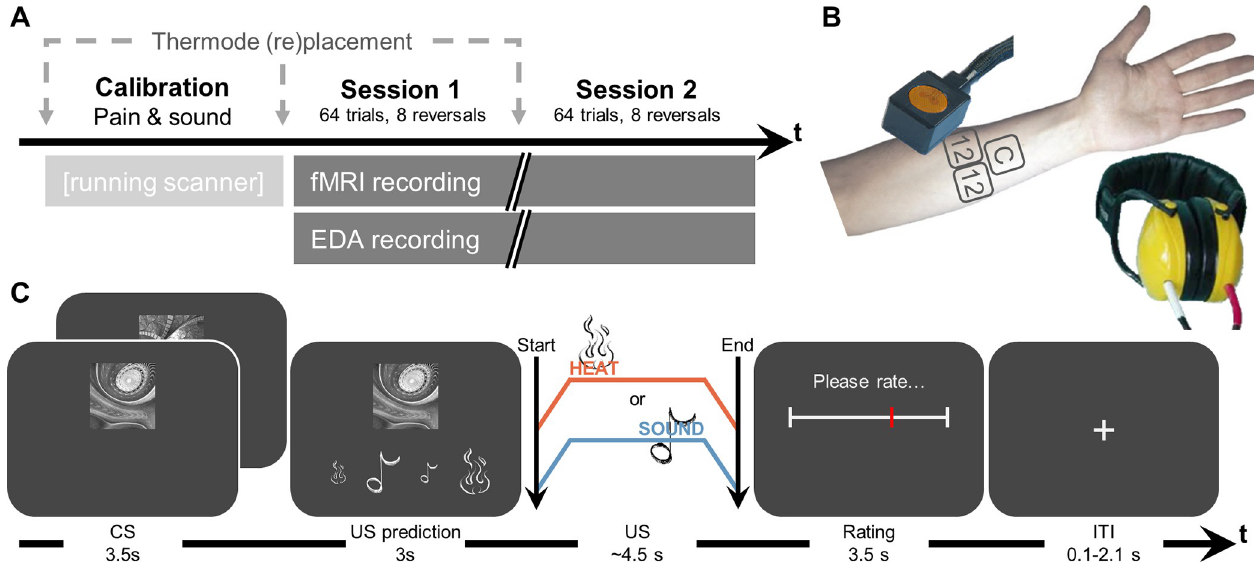
Fig 1. Experimental protocol. (A) Overall structure of the experiment. Calibration took approximately 15 minutes, each session approximately 20 minutes. (B) Devices used for heat stimulation (thermode) and sound stimulation (headphones), with standardized locations on the left arm for pain calibration and either of the 2 experimental sessions. (C) Trial structure with associated durations. After displaying CS, participants were asked to choose which US they expected to follow. The US was then applied and rated in terms of its painfulness (for pain)/unpleasantness (for sound). EDA, electrodermal activity; CS, conditioned stimuli; US, unconditioned